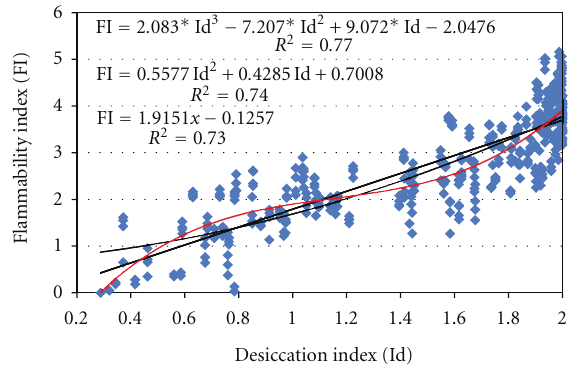
Figure 3: Flammability index (FI) values of Moroccan species as a function of their desiccation index Id.